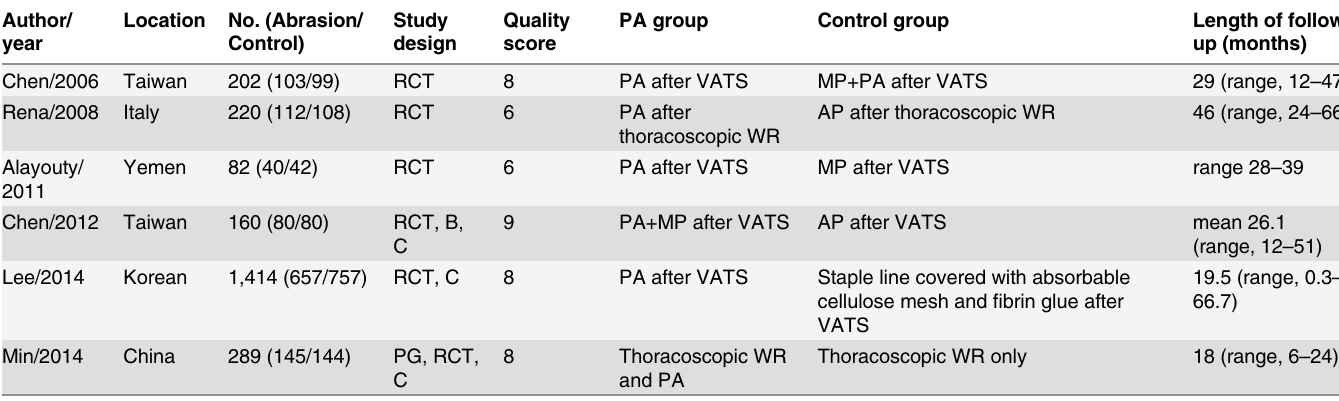
Table 1. Characteristics and quality scores of RCTs included in this systematic